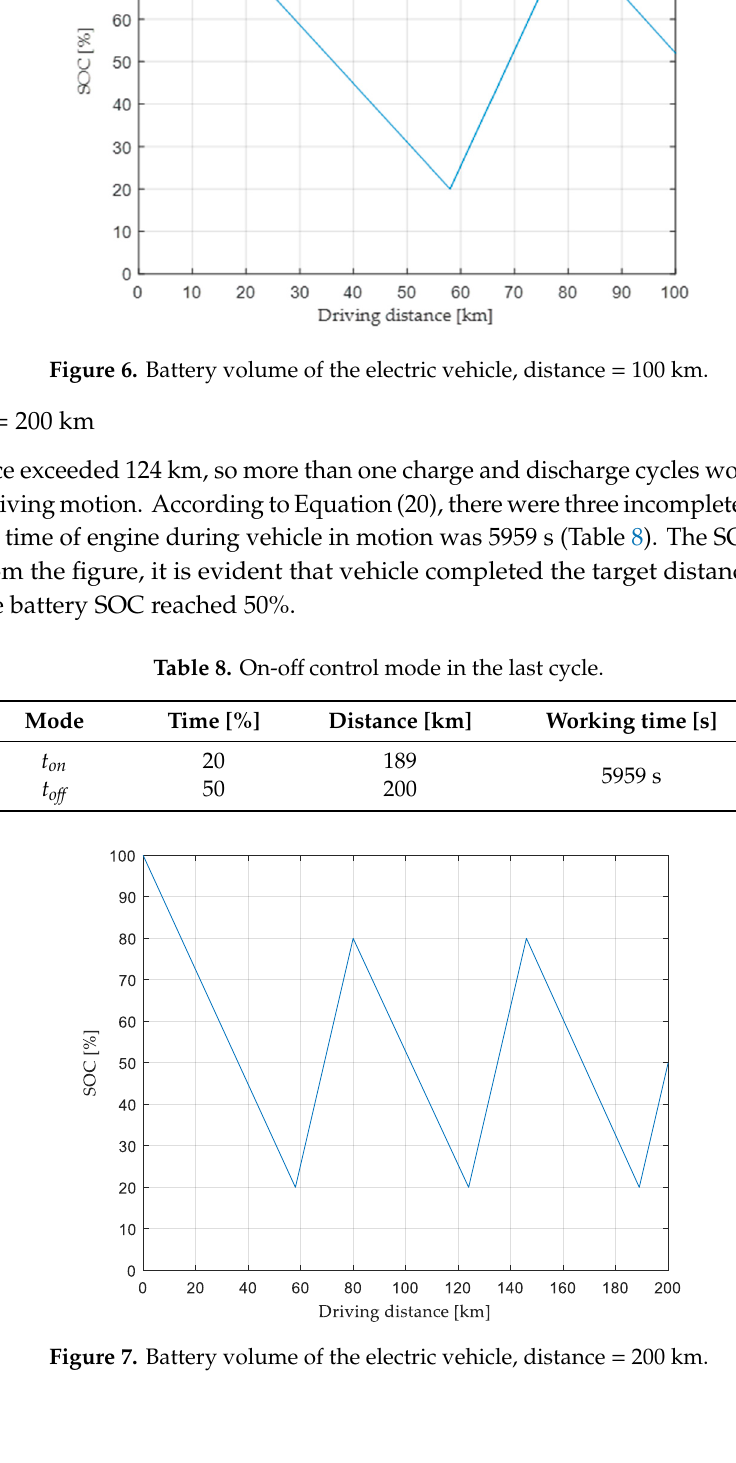
80 Figure 8. Convergence curve of engine uptime optimized via BSAII.